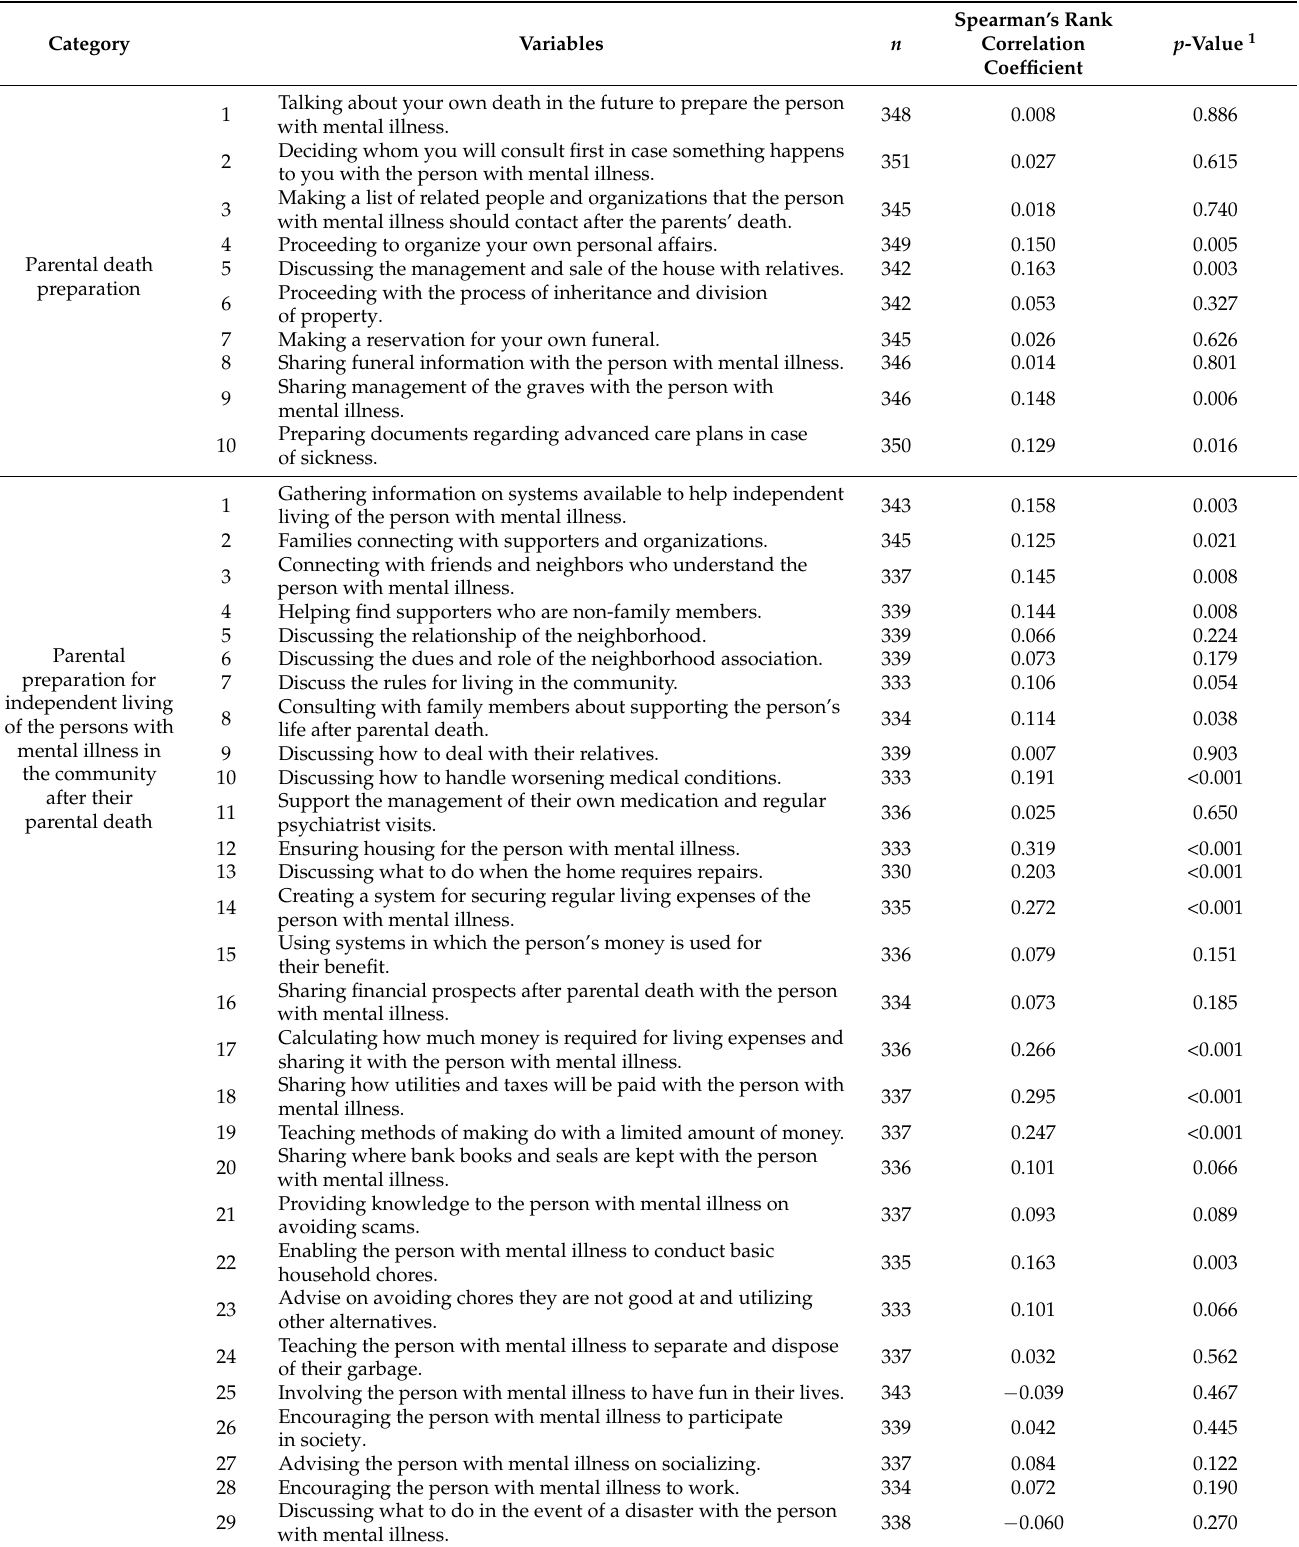
Table 2. Parental preparations for their death and the independent living of their children with mental illness after the death ( N =